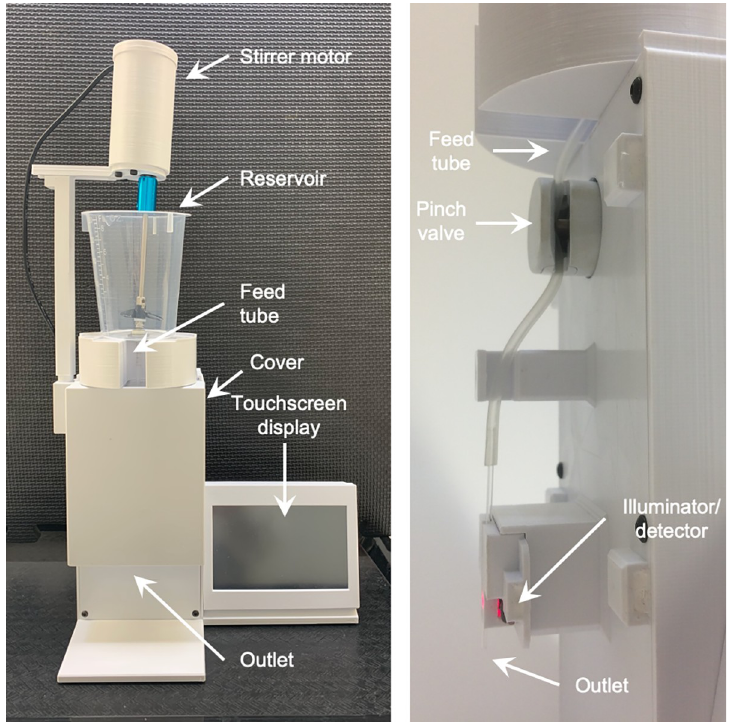
Fig 1. The Automated Particle Counter. The entire device viewed from the front (left) and (right) the major water stream components are shown viewed from the side with the main cover removed. The capillary shown has an ID of 1 mm. The reservoir shown contains 250 ml and the light source LED chosen was red. Other possible light options include green and infrared.